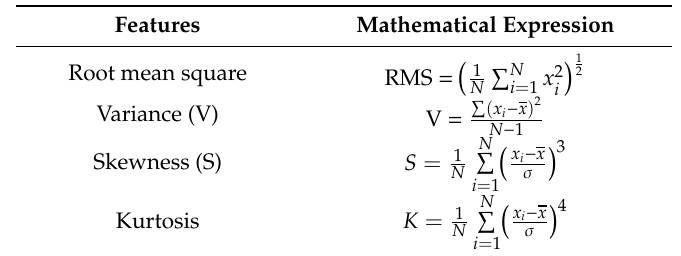
Table 5. Statistical time domain features ( x is the sensor